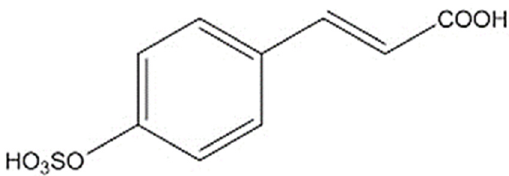
Figure 1. Chemical structure of ZA.